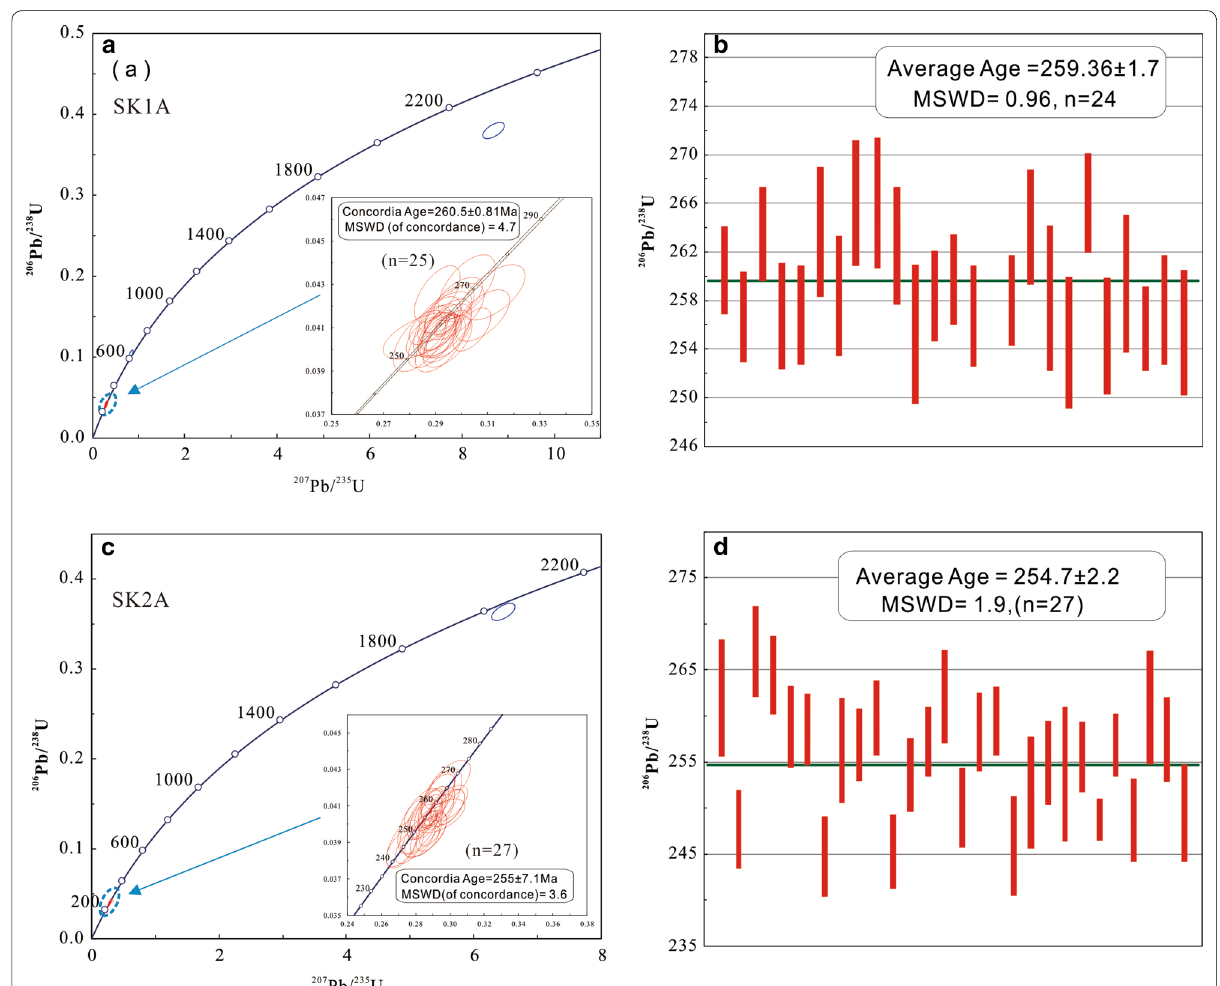
Fig. 7 Concordia plots for zircons of augengneisses and their weighted mean average 206 Pb/ 238 U